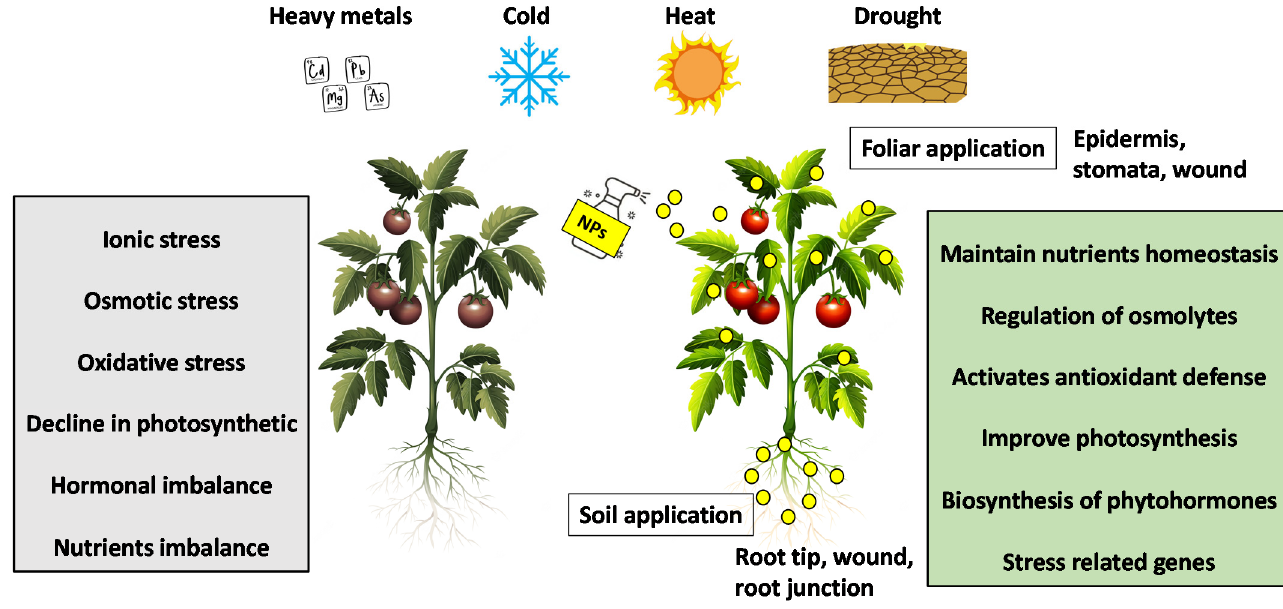
Figure 1. Mechanisms of NPs mitigate abiotic stresses in plants.